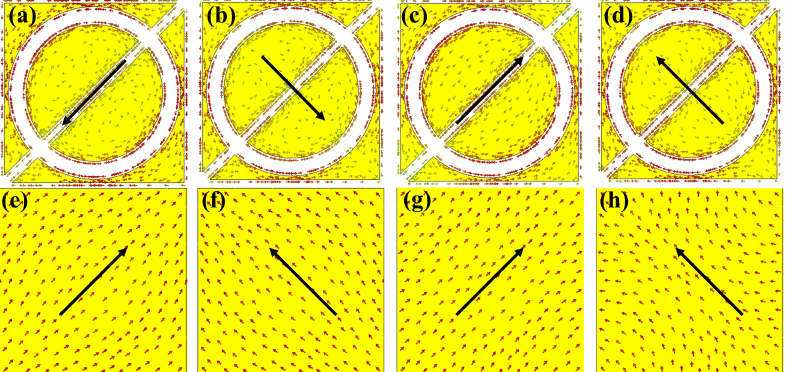
Figure 7. Surface current distribution on the ( a – d ) top and ( e – h ) bottom layer at 11.84, 17.03, 23.90, and 28.75 GHz,